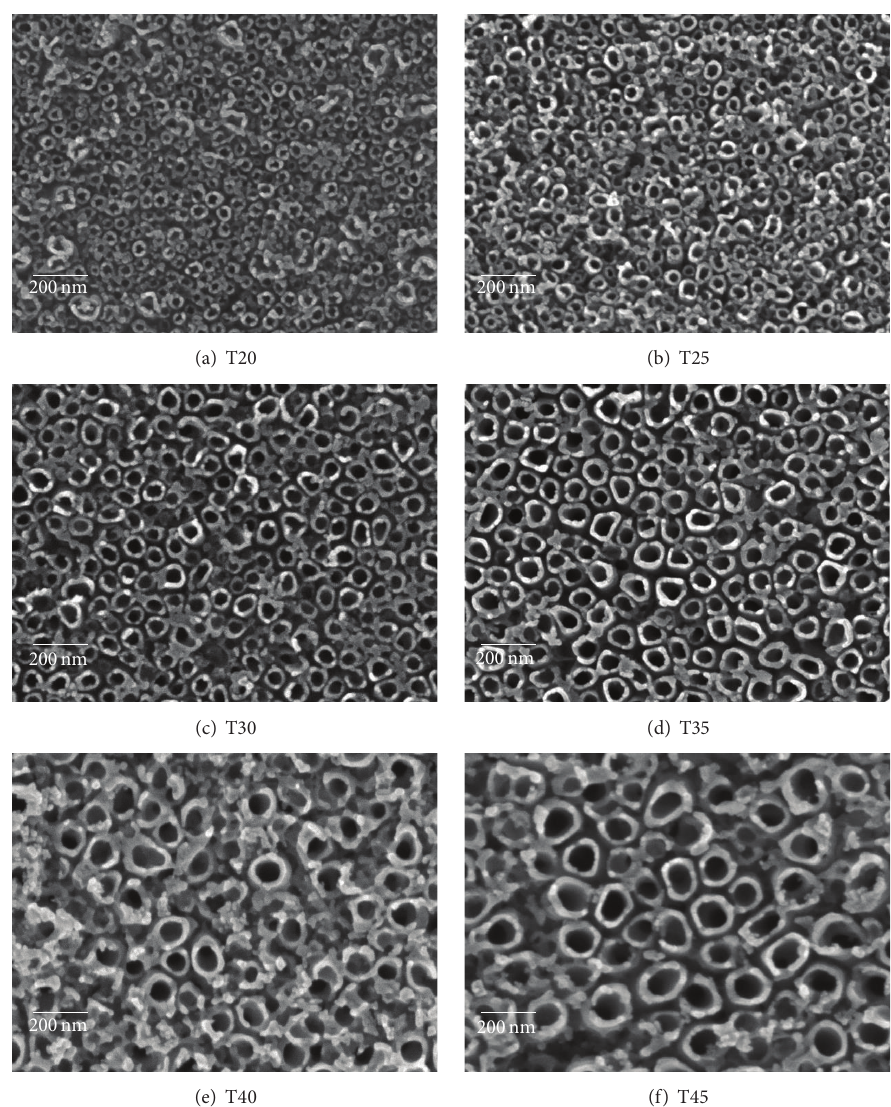
Figure 3: Top-view SEM images of TNAs prepared at different anodizing